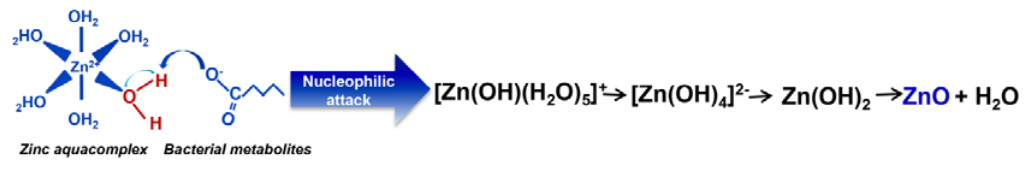
Figure 5. The proposed mechanism of ZnO NC formation.